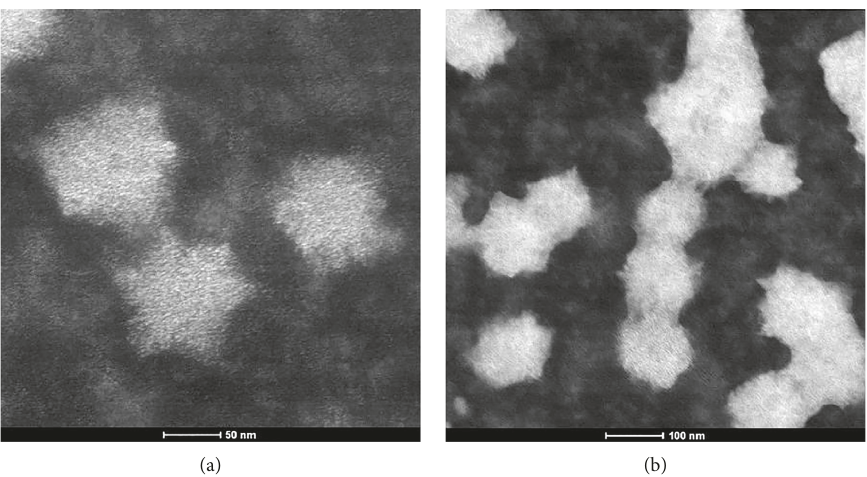
Figure 13: STEM images recorded for MnTTPCl treated with β